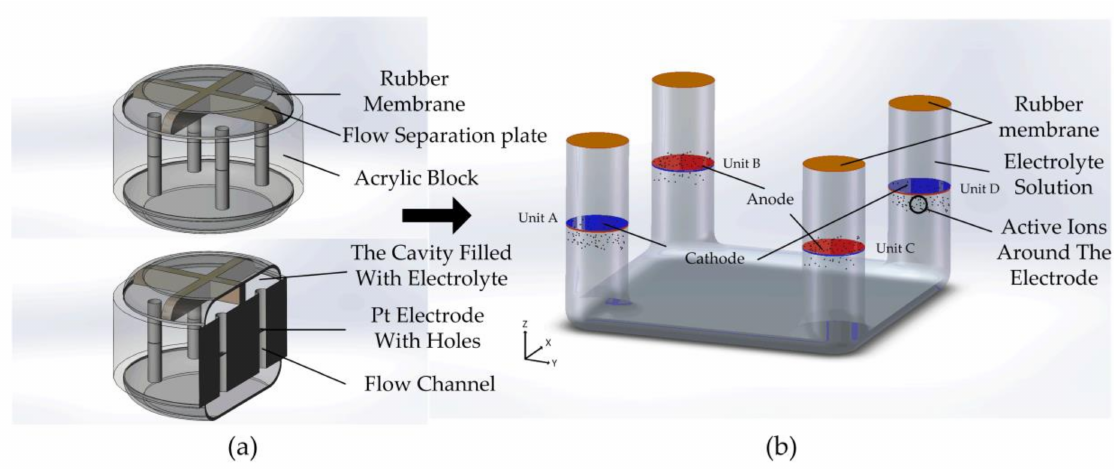
Figure 1. ( a ) Overall views and cross-section views of the proposed device with four flow channels and sensing units inside them. ( b ) The simplified schematic of the liquid part in the proposed